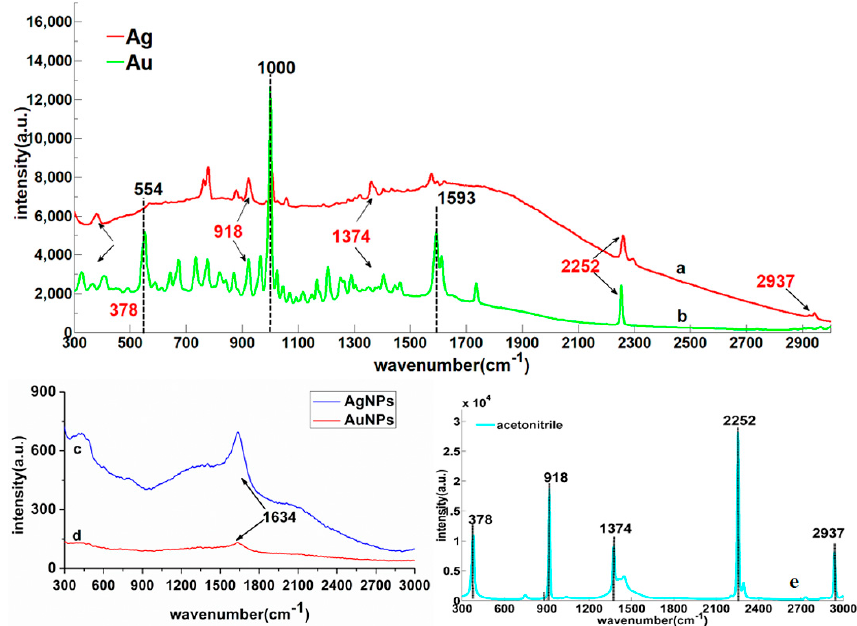
Figure 5. The SERS of deltamethrin solution based on two nanoparticles: (a) AgNPs; (b) AuNPs; the SERS of two nanoparticles; (c) AgNPs; (d) AuNPs; the RS of acetonitrile; (e) acetonitrile.